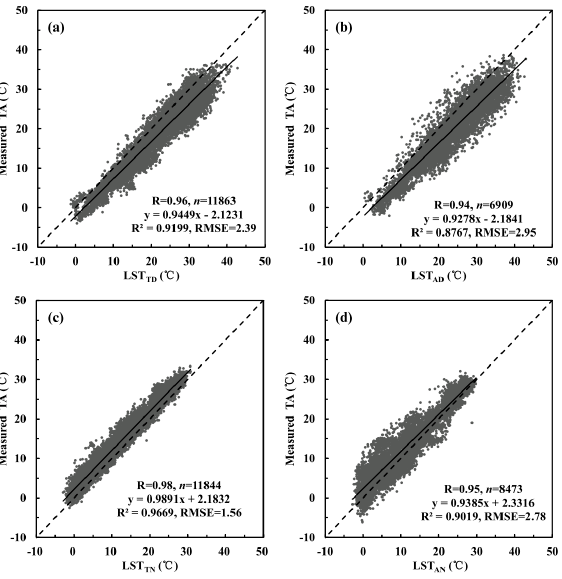
Figure 4. Scatter plots of measured air temperature (TA) form meteorological stations versus daytime and nighttime MODIS LSTs derived from both Terra and Aqua satellites at the four overpass times (2006–2011): ( a ) Terra daytime (LST TD ); ( b ) Aqua daytime (LST AD ); ( c ) Terra nighttime (LST TN ); and ( d ) Aqua nighttime (LST AN ).